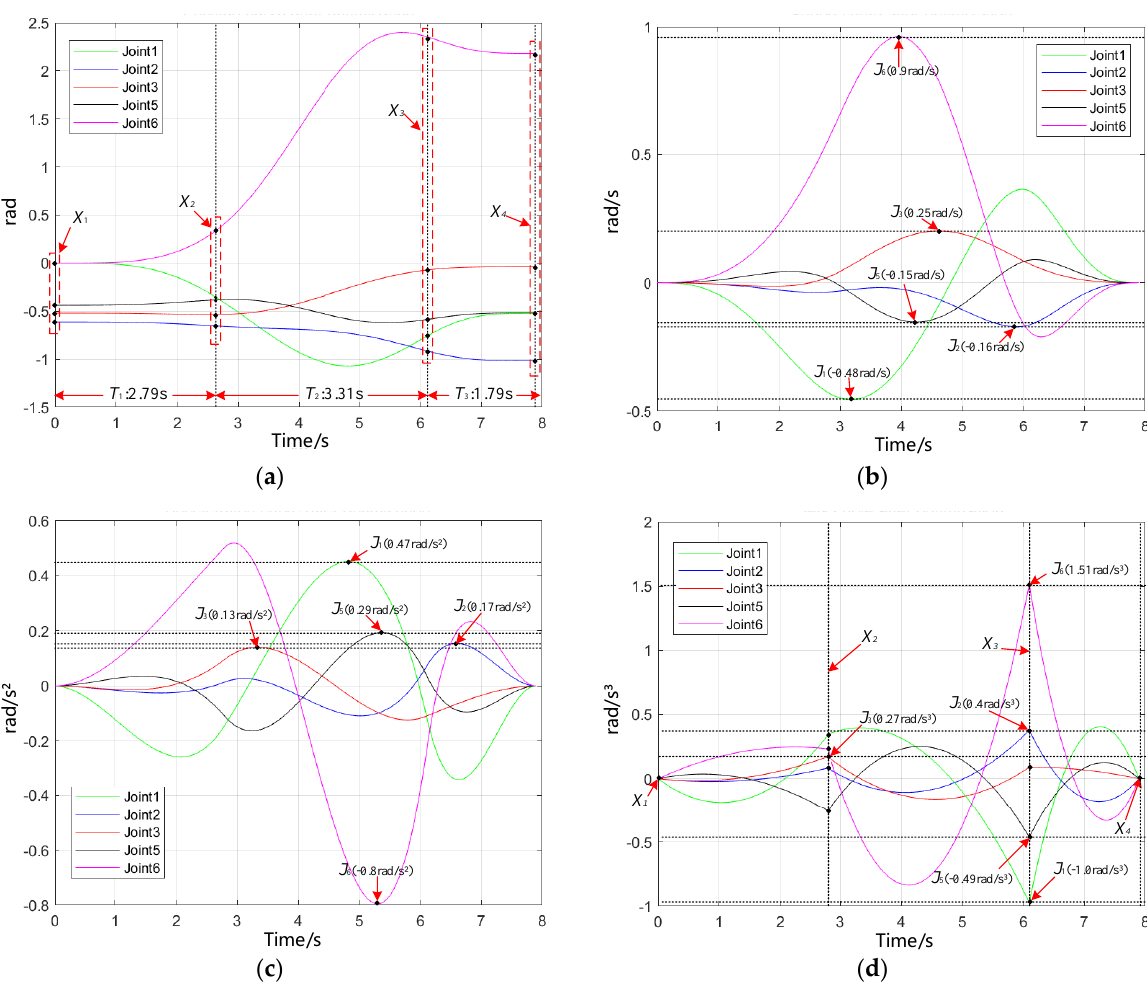
Figure 13. Joint motions after optimization: ( a ) Position curve; ( b ) Velocity curve; ( c ) Acceleration curve; ( d ) Jerk curve. After the optimization, the time comparison of the four paths is shown in Table 6. Table 6. Times of the four sections before and after the algorithm is improved (unit: s).